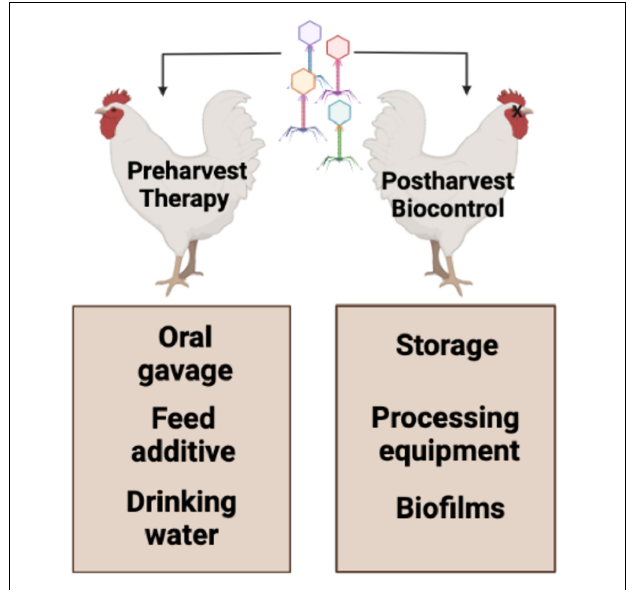
FIGURE 2 | Poultry pre- and post-harvest phage applicability. Figure was created with